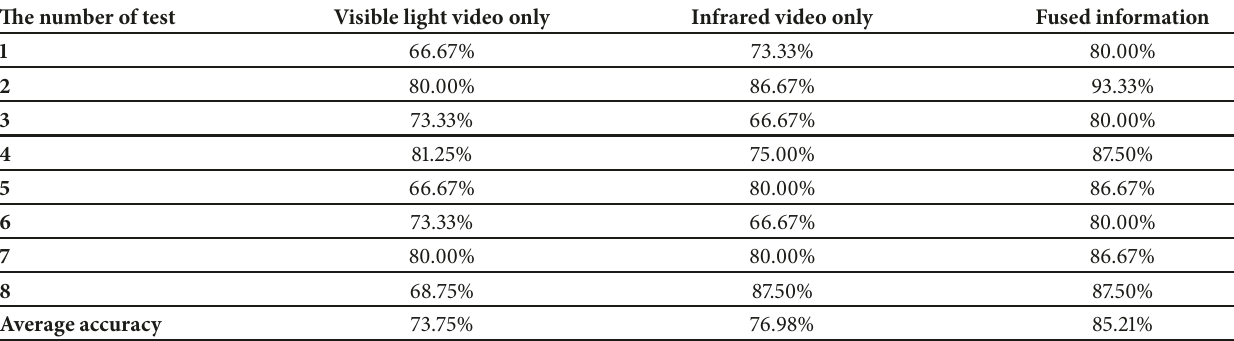
Table 6: The results of 8-fold cross validation.